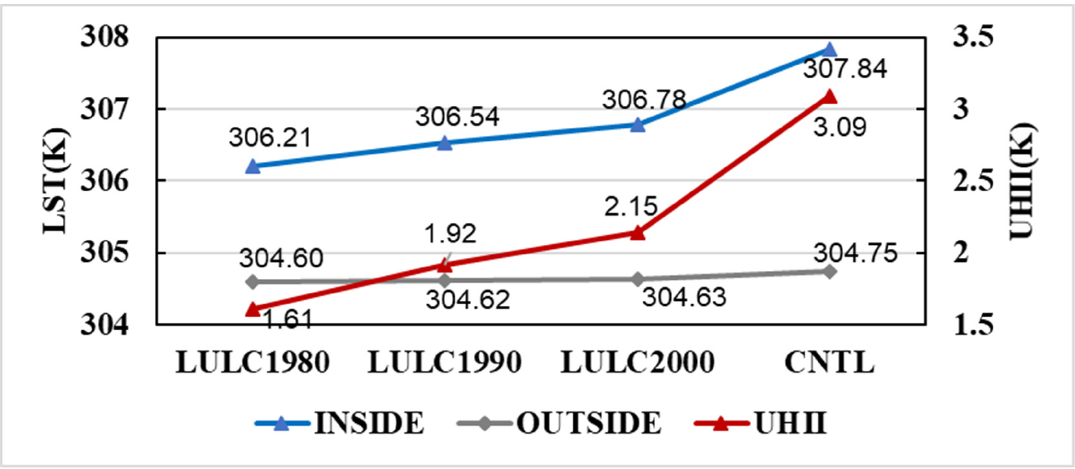
Figure 6. The LST (Unit: K) and UHII (Unit: K) for the cases LULC1980, LULC1990, LULC2000, and CNTL. The blue line is the averaged LST inside the third ring road; the gray line shows the averaged LST outside the third ring road but within the administrative boundary; the red line represents the UHII.